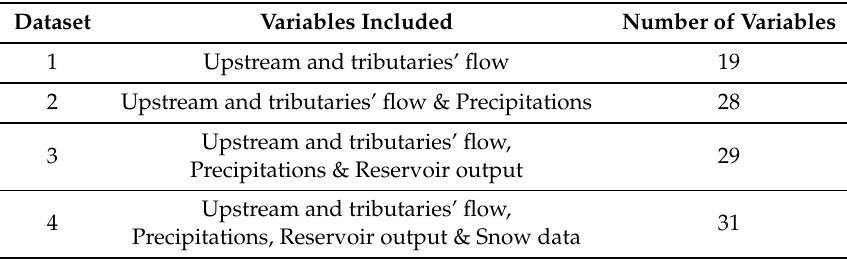
Table 2. Input variables included in each of the datasets used in the experimental evaluation of the ML regression techniques for short-term analysis and prediction of dammed water level at